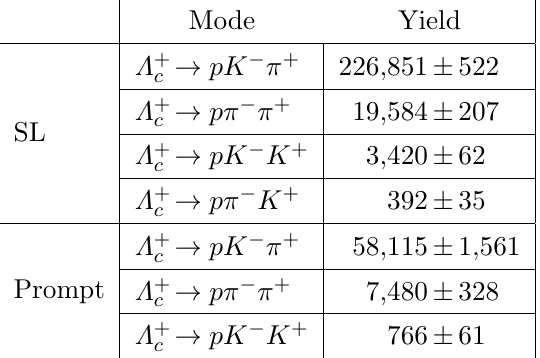
Table 2 . Signal yields in both the SL and prompt